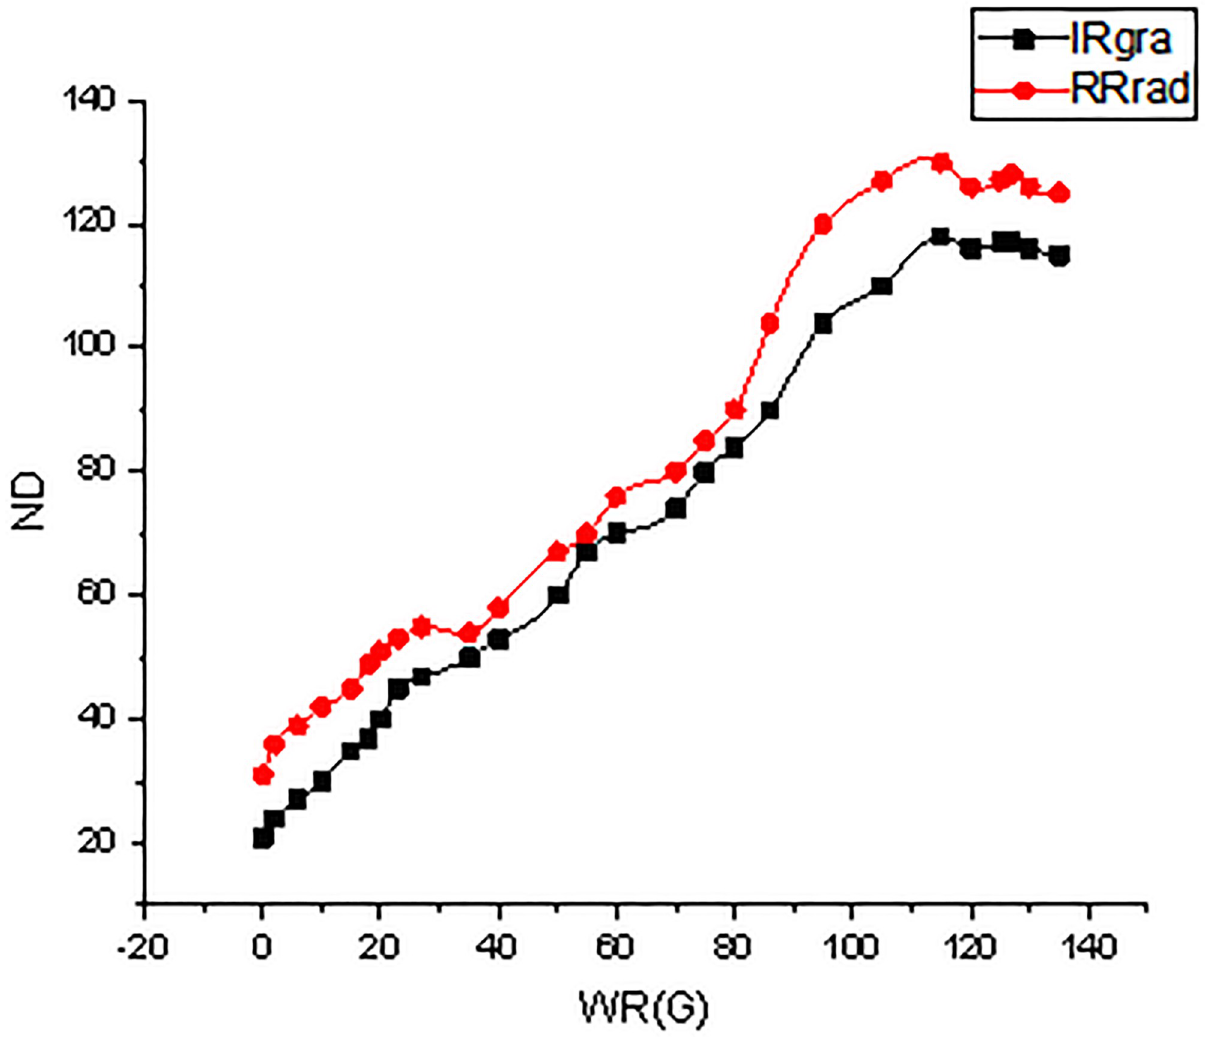
Fig 7. The change trend of new dynamic energy of manufacturing enterprises in the second stage with the change in different ways.